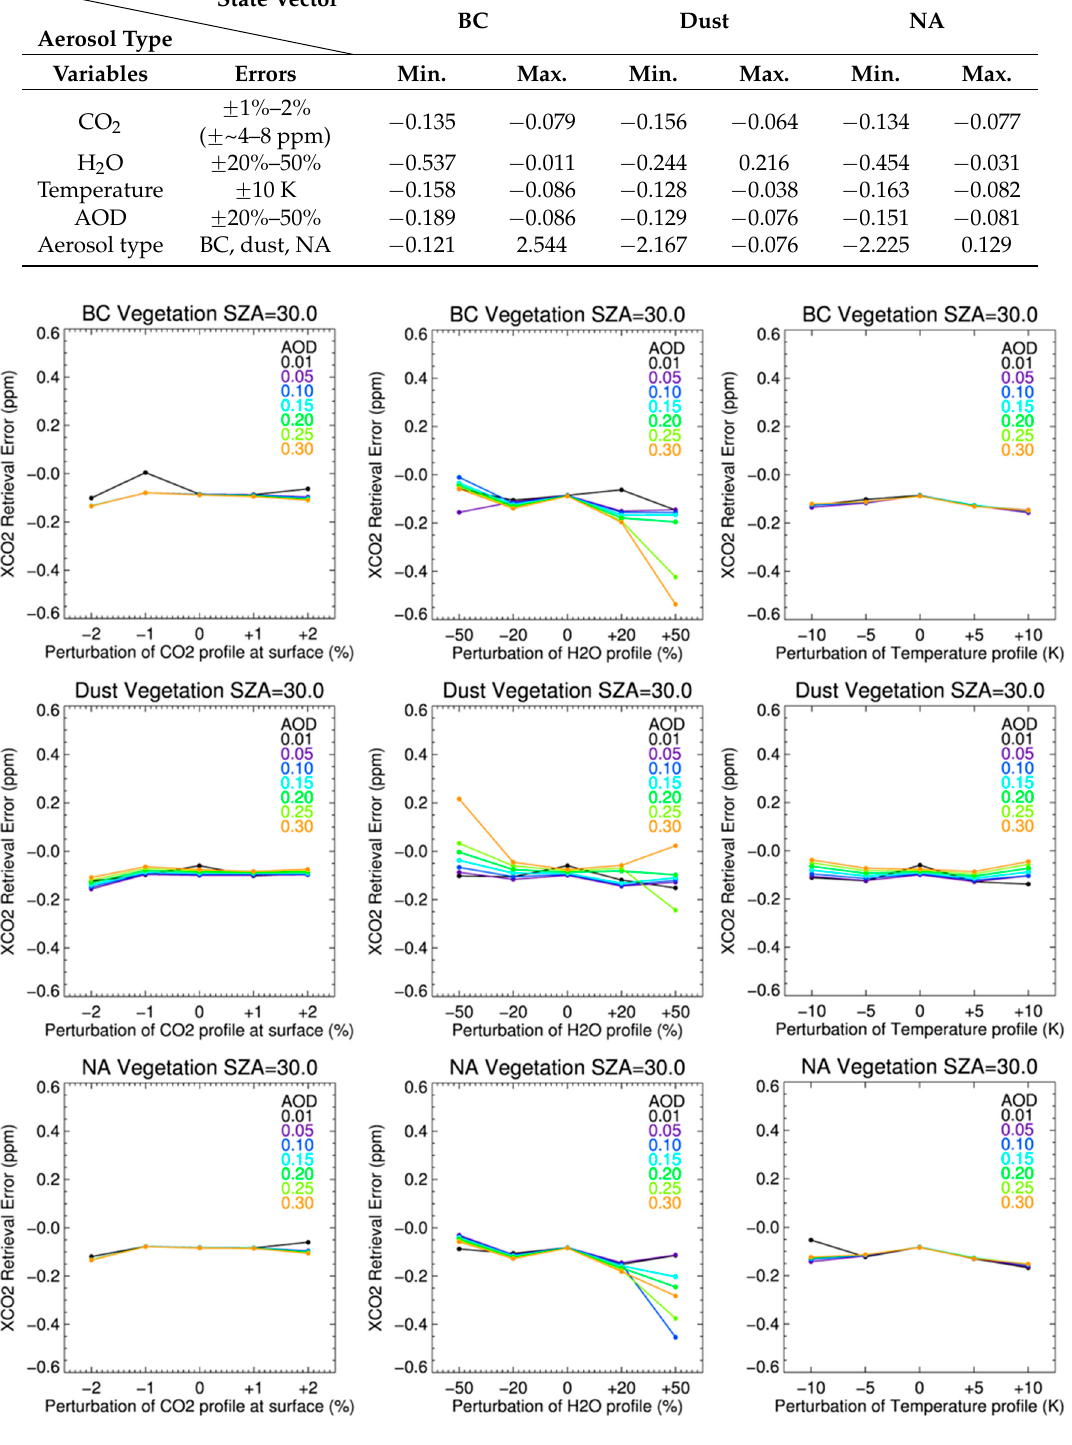
Figure 5. The XCO 2 retrieval errors for BC ( top panel), dust ( middle panel) and NA ( bottom panel) aerosol type with respect to the perturbed CO 2 profiles ( left column), H 2 O profiles ( middle column) and temperature profile ( right column) for a SZA of 30° over vegetation, respectively.